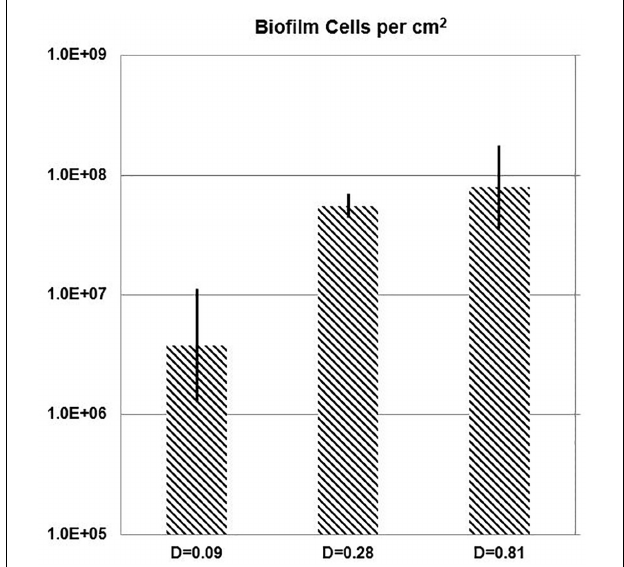
FIGURE 7 | One-day biofilm. Cell density of E. faecalis on a biofilm slide glass surface (Syto 9) estimated with Imaris Point Viewer (bars indicate ± SD) at three different dilution rates ( D; h − 1 ).